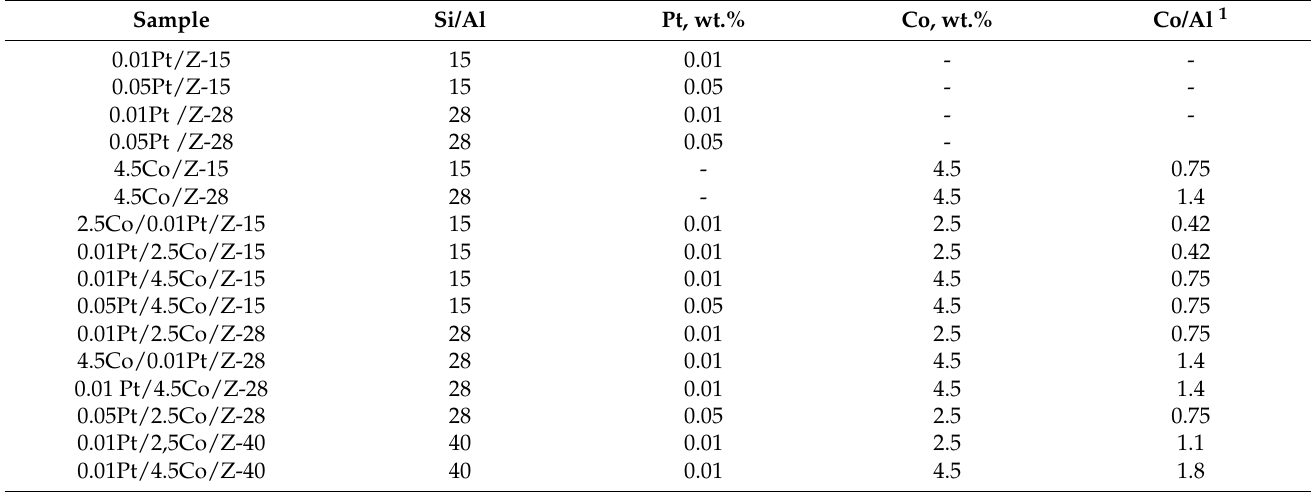
Table 1. Pt- and Co-modified HZSM-5